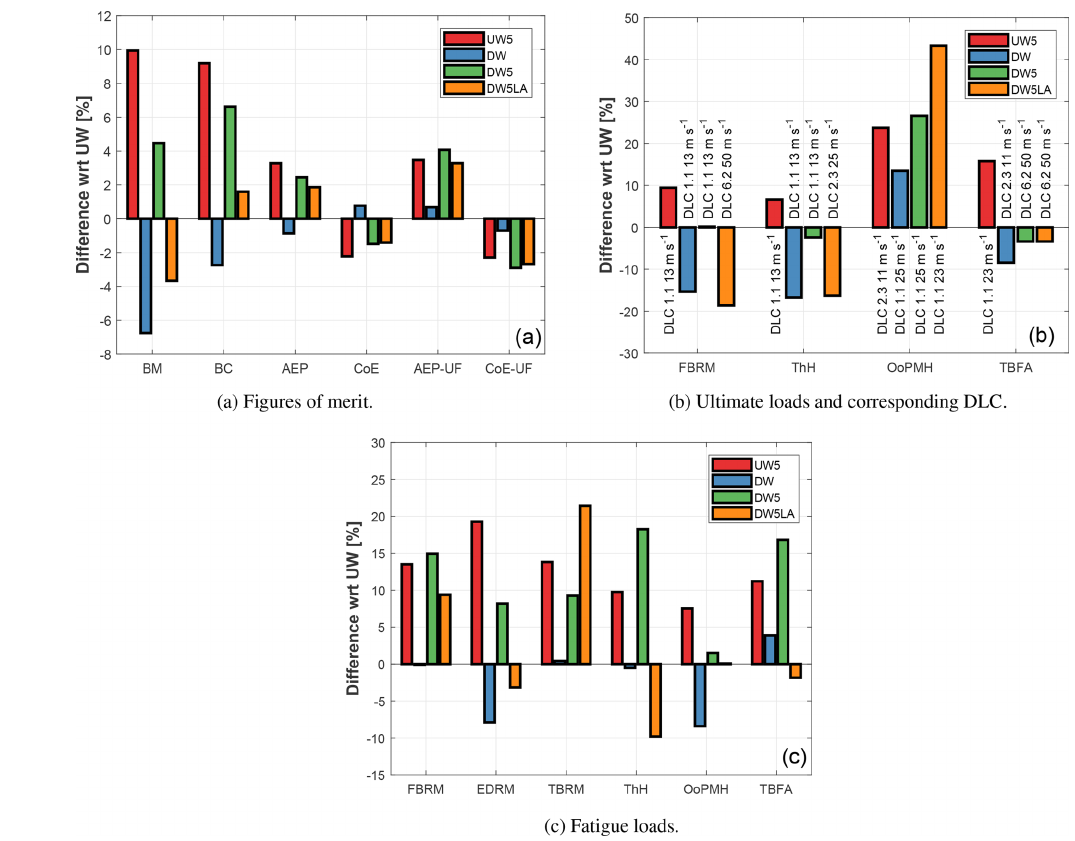
Figure 4. Comparison in terms of main figures of merit (a) , ultimate loads (b) and fatigue loads (c) for the four designs with respect to the baseline configuration UW. The CoE of DW5LA does not include the capital cost and power consumption of the active coning system in the calculations. Legend – BM: blade mass; BC: blade cost; UF: 5 ◦ of upflow; FBRM, EBRM and TBRM: flapwise, edgewise and torsional blade root moments, respectively; ThH and OoPMH: thrust and out-of-plane moment at the hub, respectively; TBFA: tower base fore–aft moment. In (b) , the dominating DLCs of UW are the same of